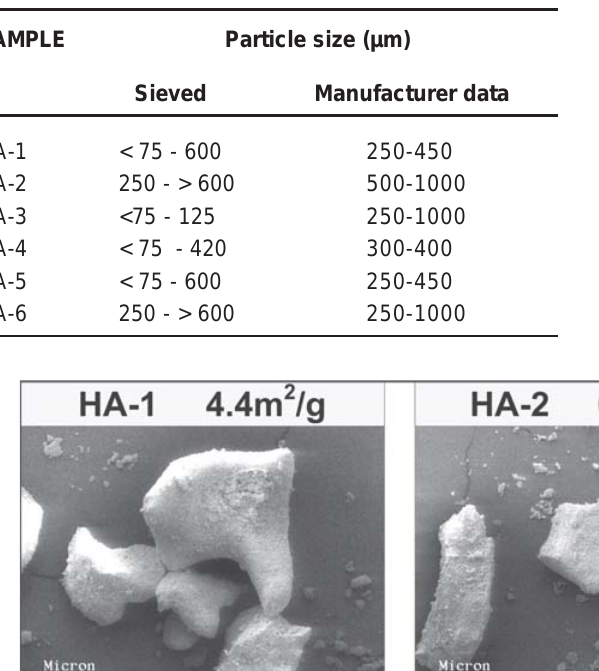
TABLE 1- Comparison between particle size determined by sieving and the manufacturers’ specifications. HA-